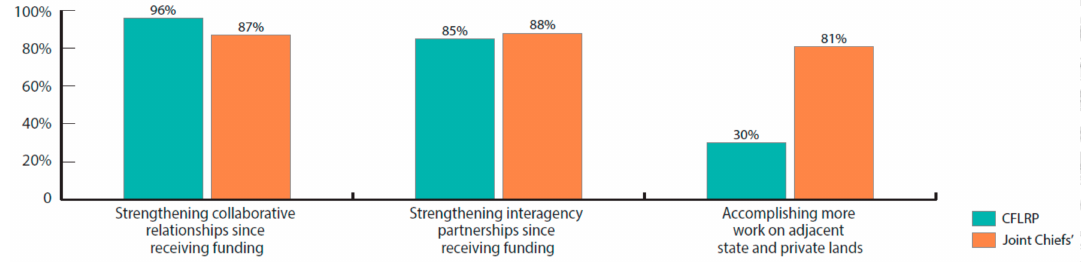
Figure 2. Percent of respondents who indicated they were moderately or very successful in making progress on different goals. Note: The items in the figures were the ones selected by the most participants and do not include all items included in the respective sections of the